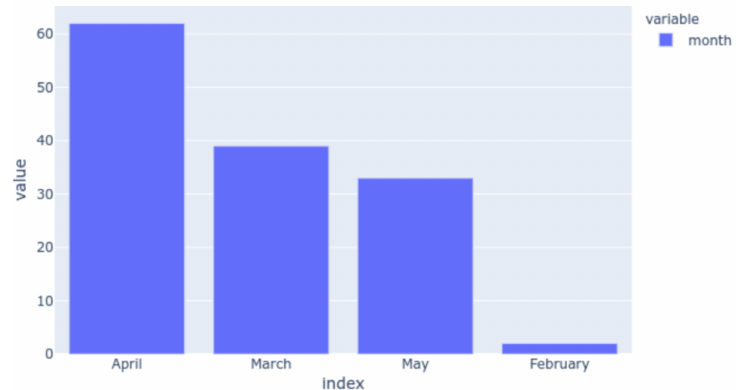
Figure 5. The distribution of the onset months reported by the participants during the study.